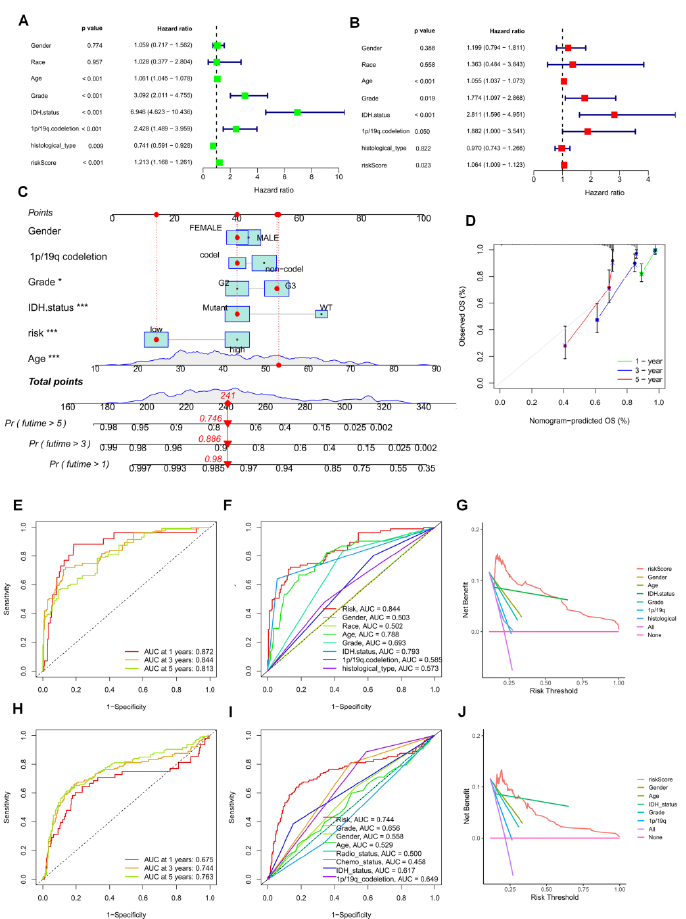
Figure 7. Prognostic value of risk scores in patients with LGG. TCGA cohort ( A ) Univariate and ( B ) multi-variate COX analysis to assess risk scores and clinical features (including age, grade, gender, IDH status, and 1p/19q. codeletion). ( C ) Nomogram of risk groupings and clinical characteristics predicting 1-, 3-, and 5-year survival. ( D ) Calibration curves tested for agreement between actual and predicted outcomes at 1, 3and5 years. AUC values for ( E ) TCGA and ( H ) CGGA cohort risk groupings at 1, 3, and 5 years. AUC values for ( F ) TCGA and ( I ) CGGA cohort risk groups and clinical characteristics at 3 years. DCA curves of risk scores and clinical characteristics for the ( G ) TCGA and ( J ) CGGA cohorts at 3 years. * p < 0.05, ** p < 0.01, *** p < 0.001.